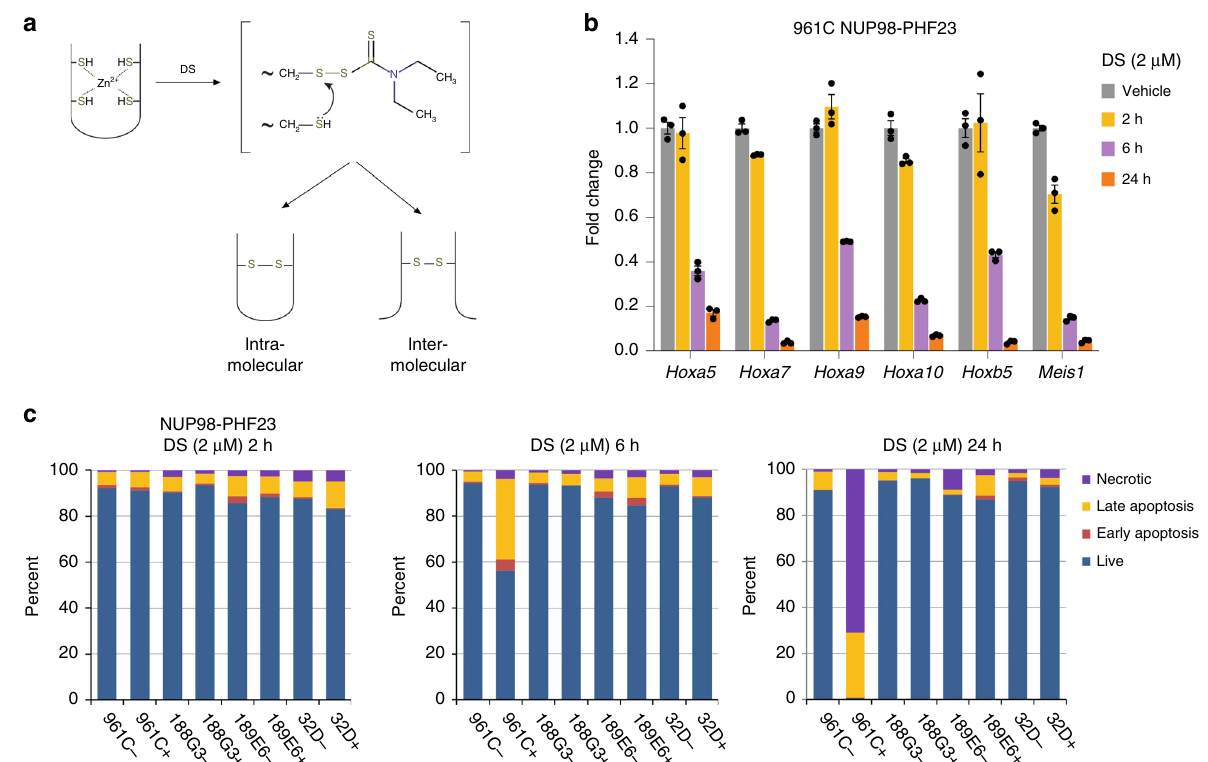
Fig. 4 DS induces cell death in NUP98 – PHF23 expressing cells. a The mechanism of DS-based inhibition. b DS treatment leads to reduced target gene expression. qRT-PCR quanti fi cation of previously identi fi ed 9 target genes normalized to 18S RNA as internal control con fi rms downregulation of Hoxa5, Hoxa7, Hoxa9, Hoxa10, Hoxb5, and Meis1 in the presence of DS. Error bars represent SEM ( n = 3 each sample). Source data are provided in the Source Data fi le. c Proportions of necrotic, late apoptosis, early apoptosis, and live cells in NUP98 – PHF23 expressing 961C, NUP98 – HOXD13 expressing 188G3 and 189E6, and control (32D) AML cell lines treated without ( − ) or with ( + ) DS. n = 1, source data are provided in the Source Data fi